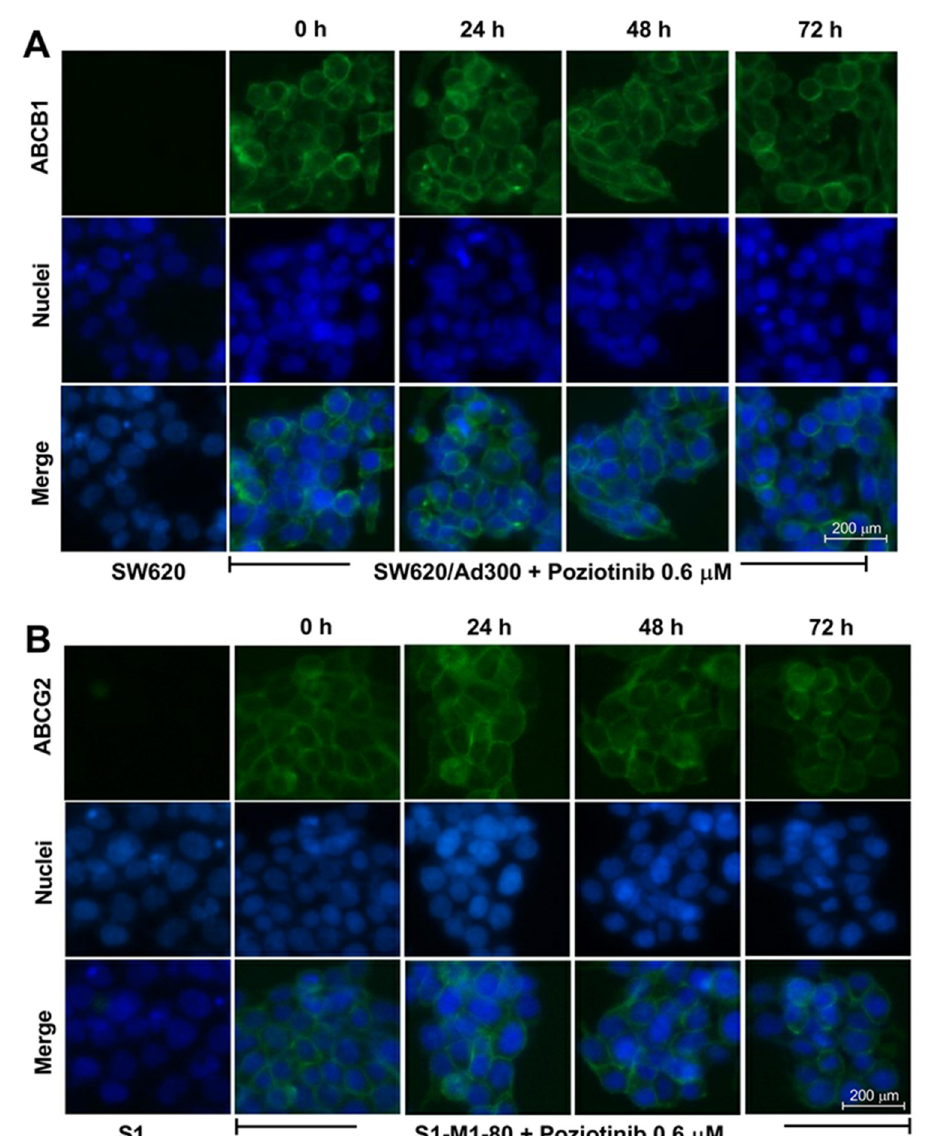
Figure 3. The e ff ect of poziotinib on the membrane localization of the ABCB1 and ABCG2 transporters. Figure 3. The effect of poziotinib on the membrane localization of the ABCB1 and ABCG2 ( A ) Cellular membrane localization of the ABCB1 transporter in SW620 / Ad300 colon cancer cells transporters. ( A ) Cellular membrane localization of the ABCB1 transporter in SW620/Ad300 colon incubated with 0.6 µ M of poziotinib for 24, 48 or 72 h ( B ) Cellular membrane localization of the ABCG2 cancer cells incubated with 0.6 μ M of poziotinib for 24, 48 or 72 h ( B ) Cellular membrane localization transporter in S1-M1-80 colon cancer cells incubated with 0.6 µ M of poziotinib for 24, 48 or 72 of the ABCG2 transporter in S1-M1-80 colon cancer cells incubated with 0.6 μ M of poziotinib for 24, 48 or 72 h.